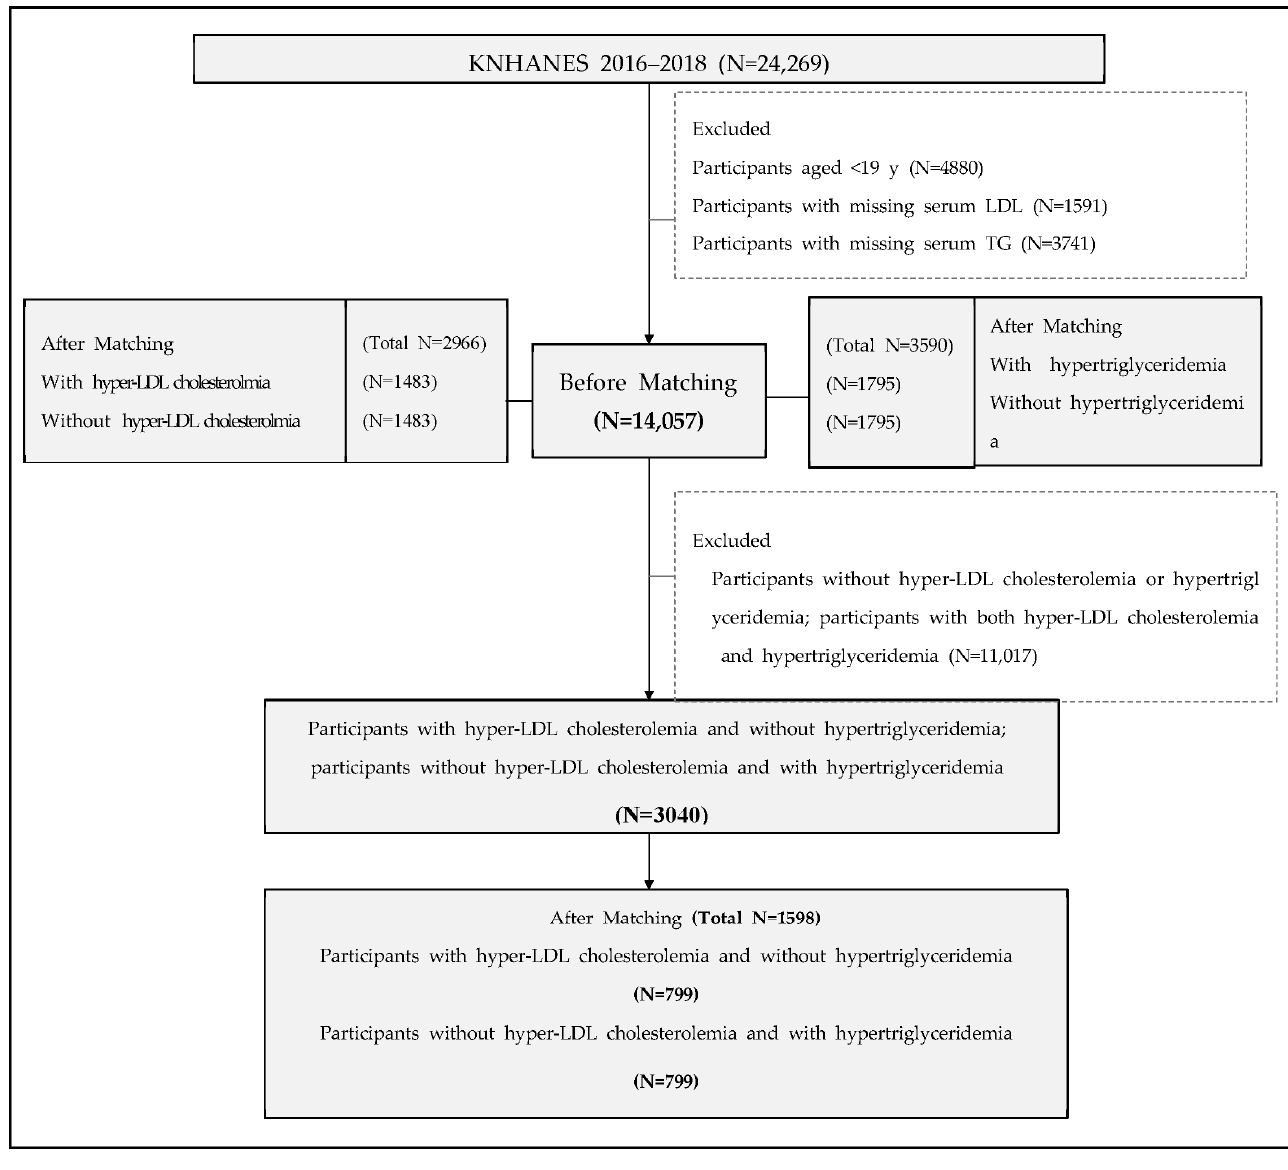
Figure 1. Study flow chart. KNHANES, Korea National Health and Nutrition Examination Survey; LDL, low-density lipoprotein.